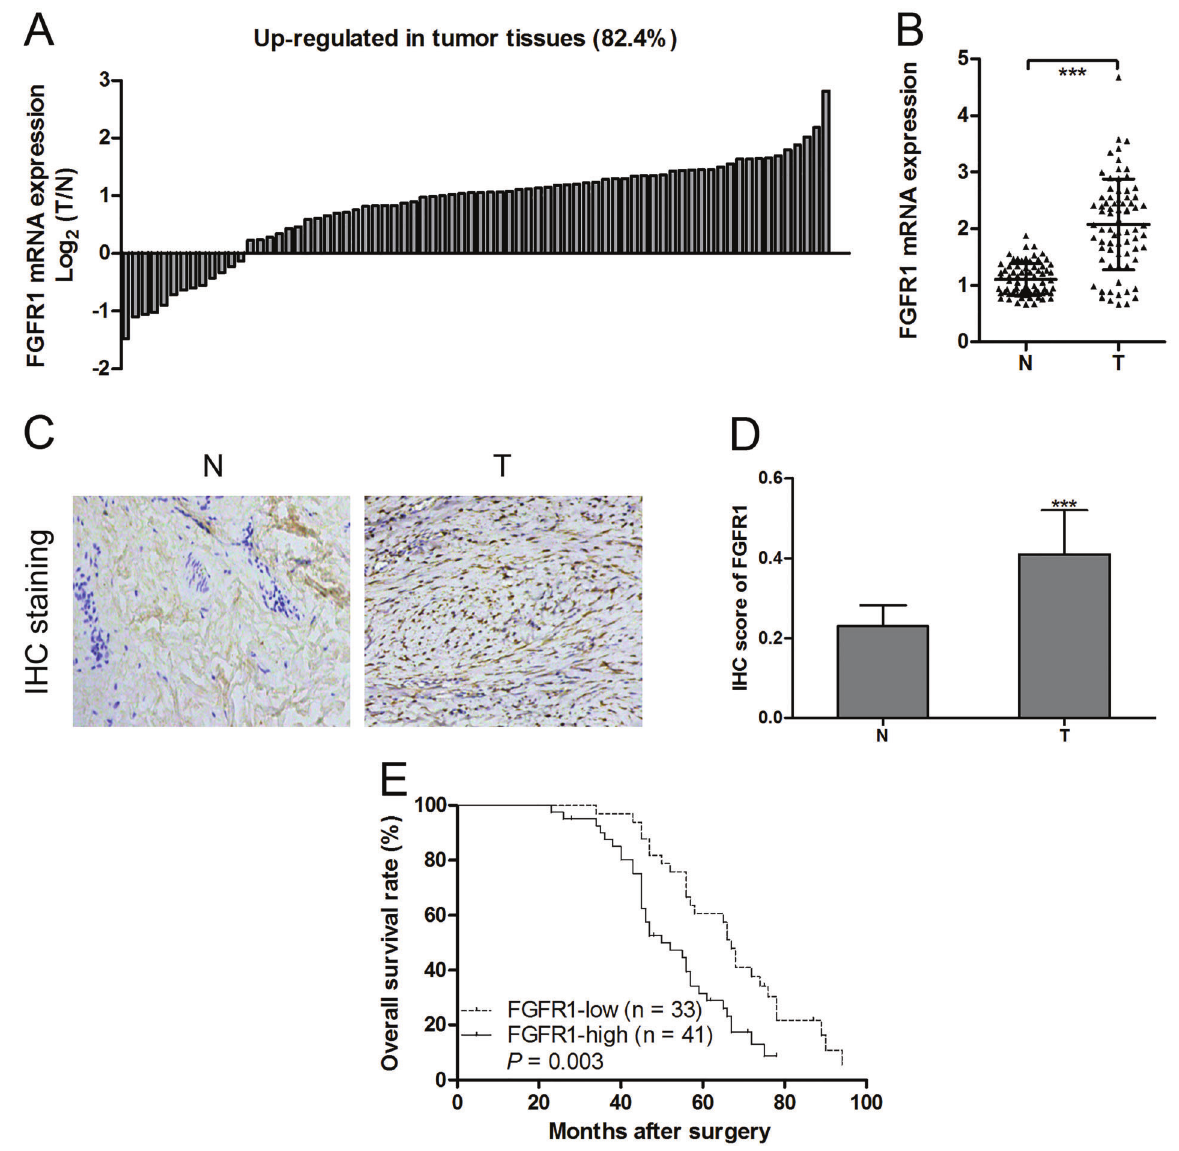
Figure 1. Expression of fi broblast growth factor receptor 1 (FGFR1) measured by RT-qPCR ( A and B ) and immunohistochemical (IHC) staining ( C and D ; magni fi cation 100 (cid:2) , 50 m m) in 74 pairs of tumor (T) tissues and adjacent non-tumorous (N) tissues from gastric cancer patients. Kaplan-Meier survival curve was used to evaluate whether FGFR1 expression levels were associated with overall survival in patients with gastric cancer ( E ). In D , data are reported as means ± SE. ***P o 0.001 ( t